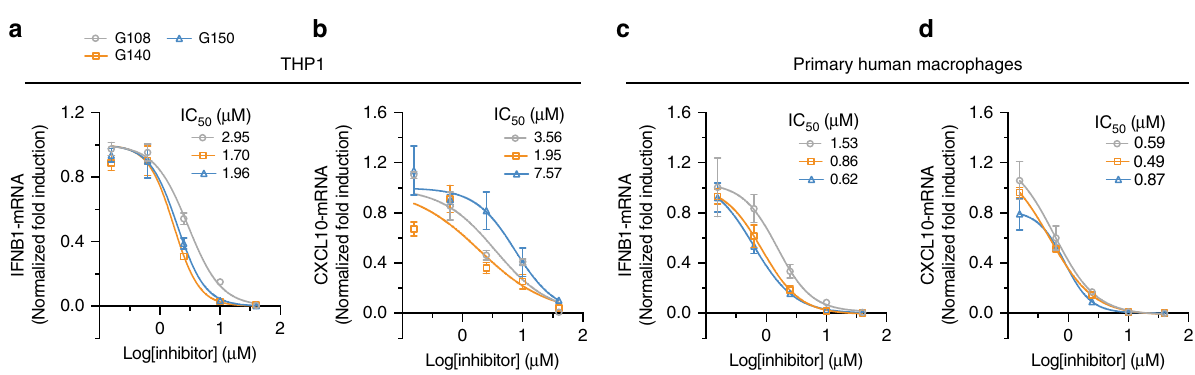
Fig. 6 G chemotype inhibitors show potent inhibition of cGAS in human THP1 and primary macrophages. a , b Potency of G108 , G140 , and G150 was tested in dsDNA-stimulated THP1 cells in the presence of a range of different inhibitor concentrations. IFNB1 ( a ) and CXCL10 ( b ) mRNA were measured by qRT- PCR for each of the indicated inhibitor concentrations and normalized to no inhibitor control. c , d Analysis of inhibition of dsDNA-induced cGAS activity by G108 , G140 , and G150 in primary macrophage cells differentiated from human blood-derived monocytes. The cellular IC 50 values were calculated using GraphPad Prism (7.01).( n = 3; mean ± S.D. Data shown are representation of two independent